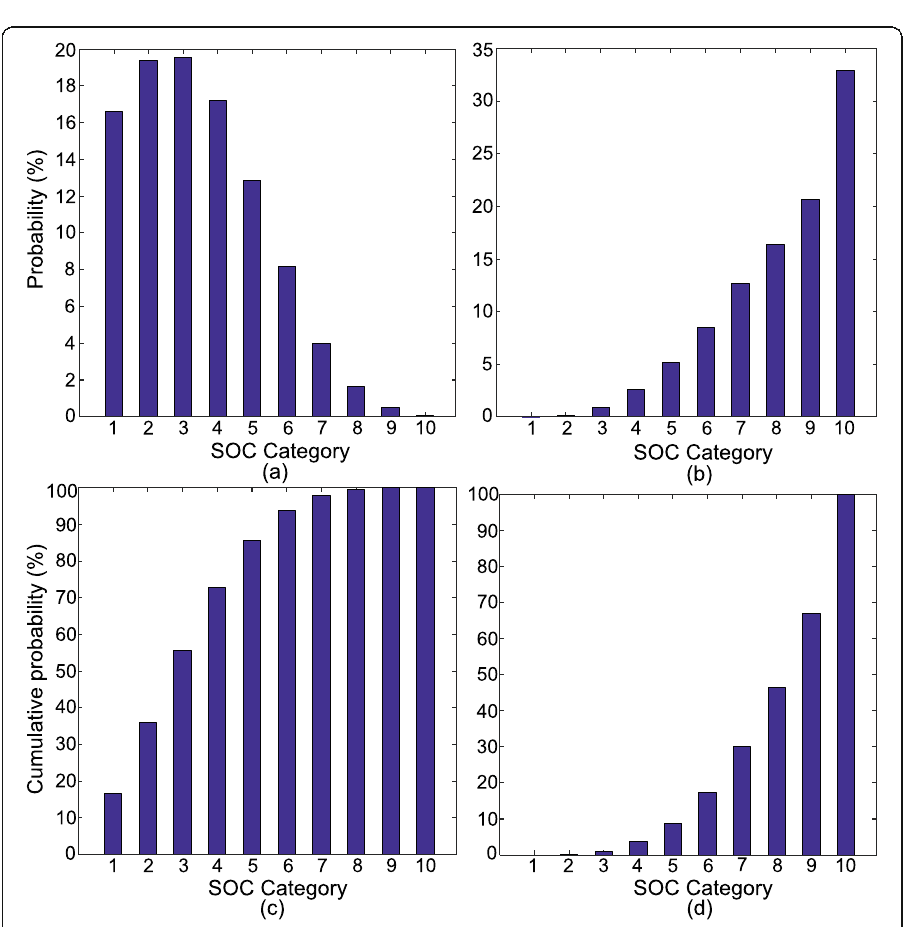
Fig. 2 a PDF of the initial SOC, b PDF of the final SOC, c CDF of the initial SOC, and d CDF of the final